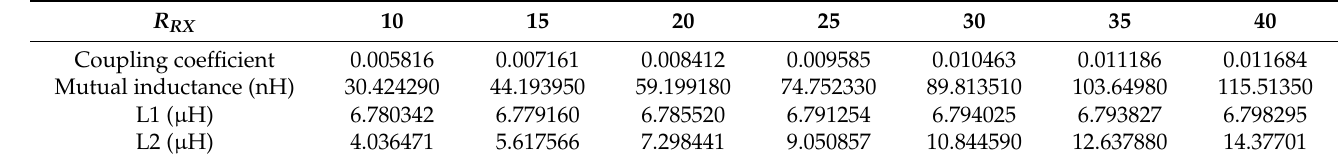
Table 6. Simulation results of circular coil model— R RX variation.